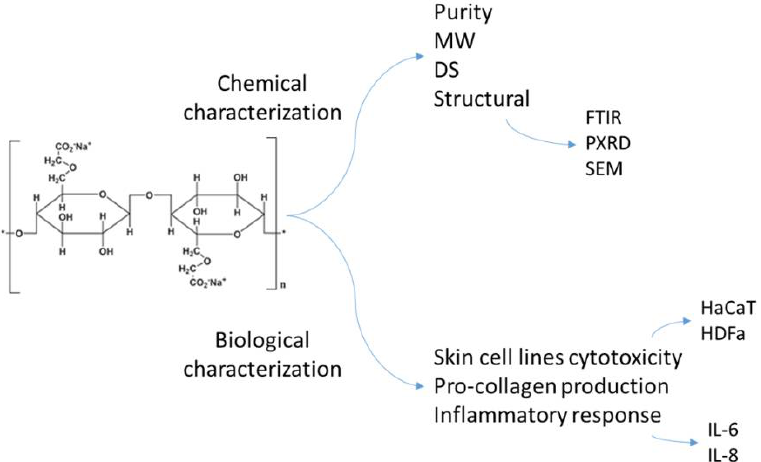
Figure 1. Scheme showing the experimental procedure taken to analyze CMC’s cosmeceutical potential.